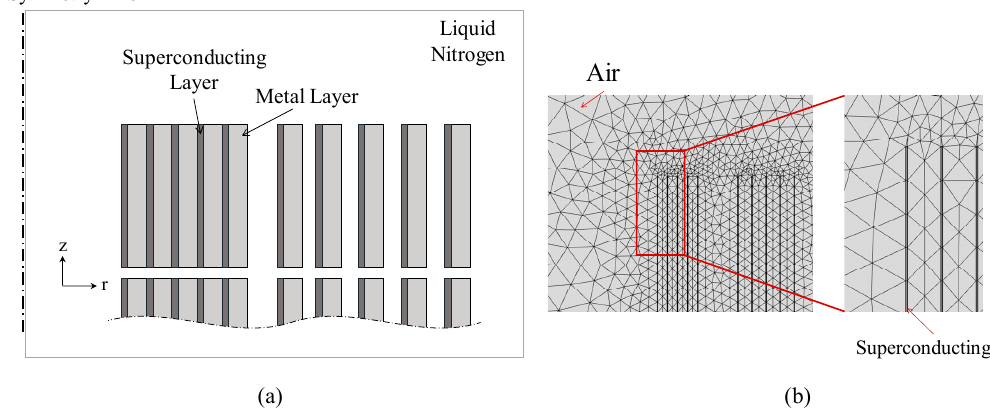
Figure 3. Schematic diagram of electromagnetic model. ( a ) Structure; ( b ) mesh.